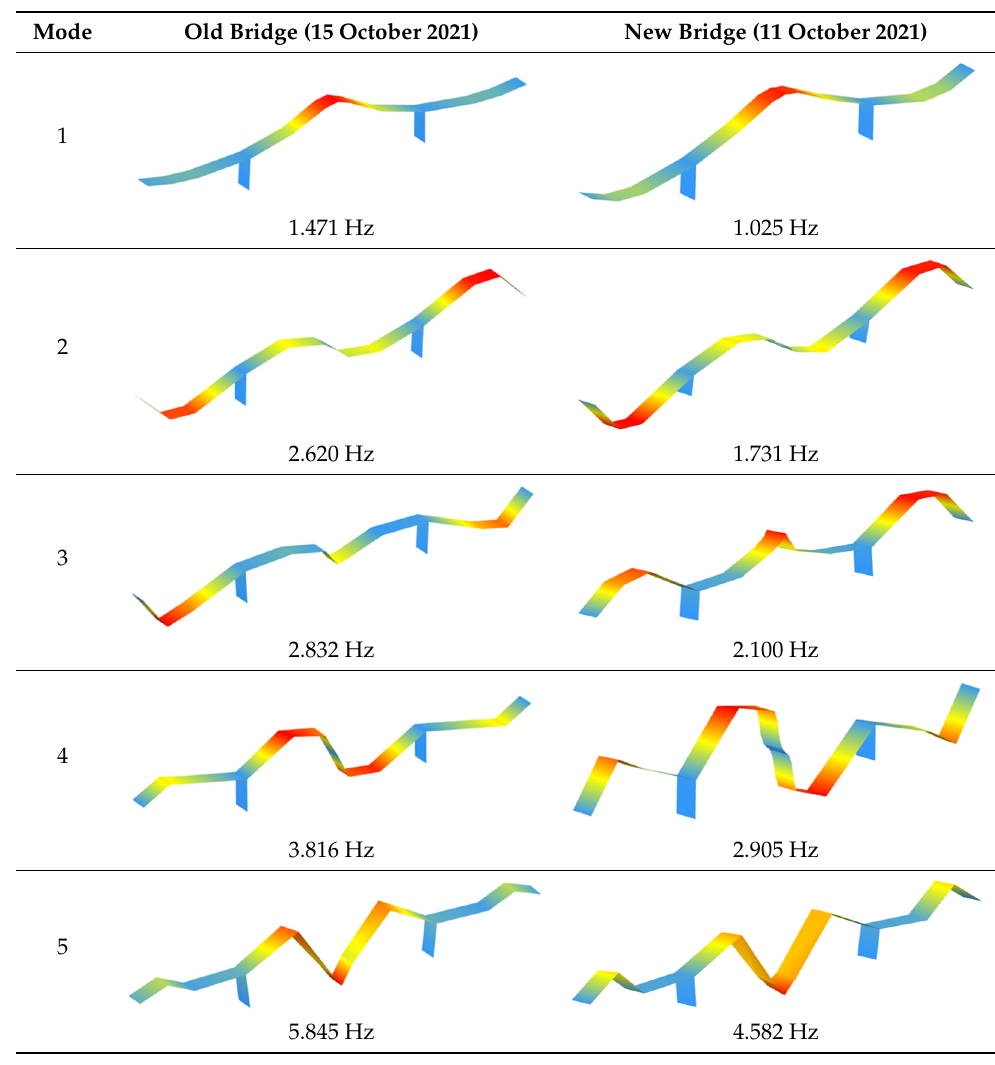
Table 3. Comparison of the modal properties using the conventional system (GeoSIG).